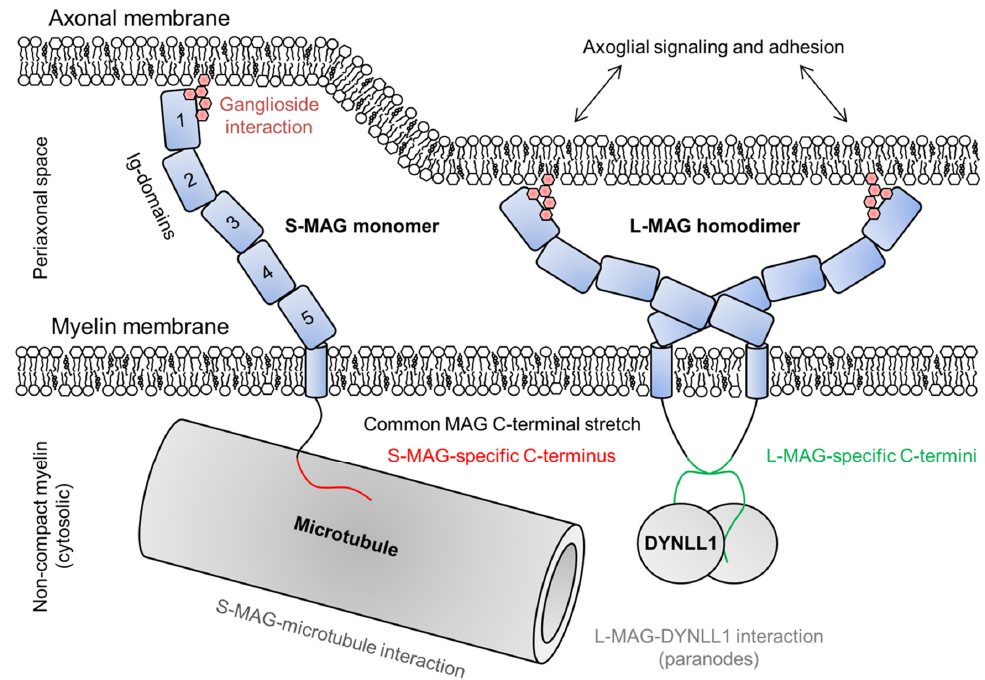
Figure 7. The roles of S- and L-MAG on both sides of the adaxonal layer. MAG is able to dimerize through Ig-domains 4 and 5, which determines the dimensions of MAG and thus the intermembrane distance within the periaxonal space [179]. MAG interacts with gangliosides on the axonal membrane and mediates bidirectional axoglial signaling [180], maintaining the width of the periaxonal space. In the cytosol beneath the adaxonal membrane, S-MAG interacts with microtubules and L-MAG with DYNLL1 [178,181].